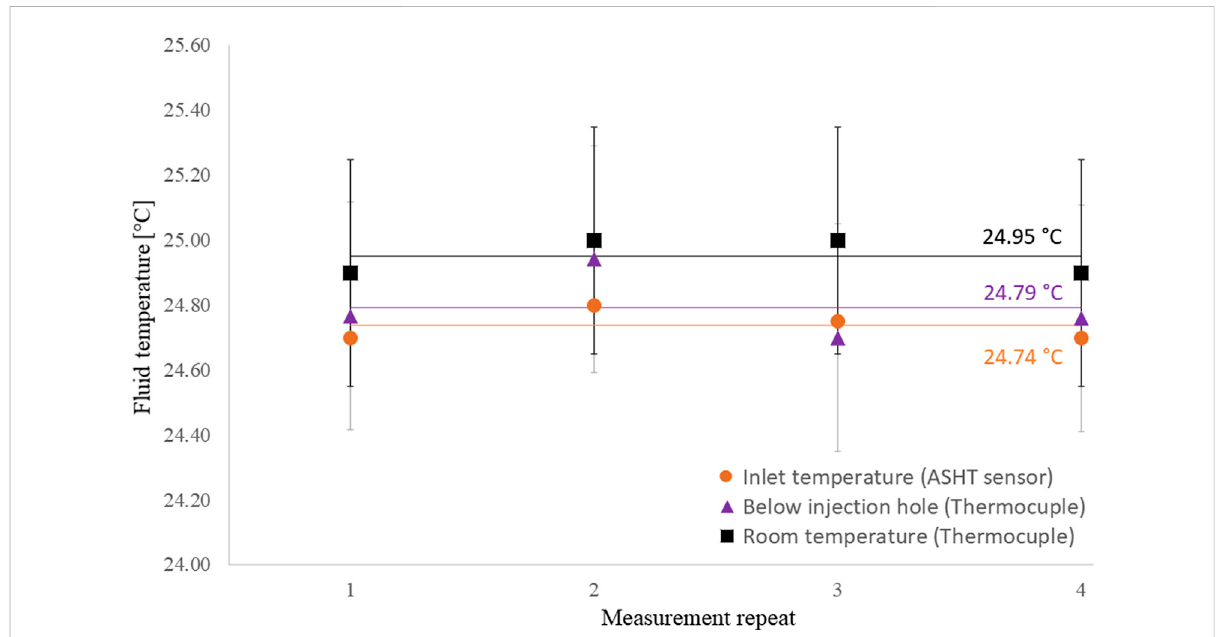
FIGURE 4 Veri fi cationofthetemperaturemeasuredbythetemperaturesensor.Thesiliconeoiltemperaturewasmeasuredattheinletbythetemperature sensors and below the injection hole by a thermocouple. The error bars represent the thermocouple accuracy (±0.002 x measured temp. + 0.3 ° C). Though the thermocouple is not as accurate as the sensor, the average temperature in both measurements (shown by the horizontal lines and values) is not signi fi cantly different and close to the room temperature value. The same silicone oil ran in the injection system a total of four times to assess if the fl uid remains at room